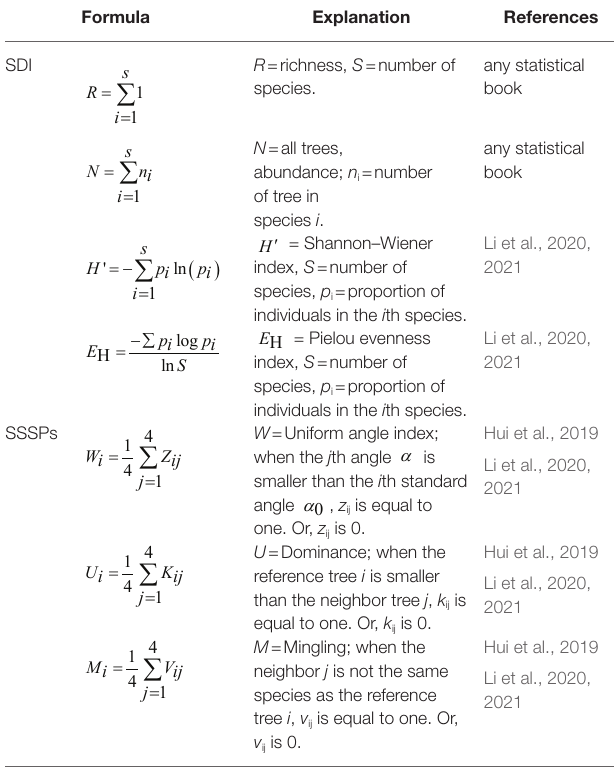
TABLE 2 | Species diversity indices and stand spatial structure parameters used in this